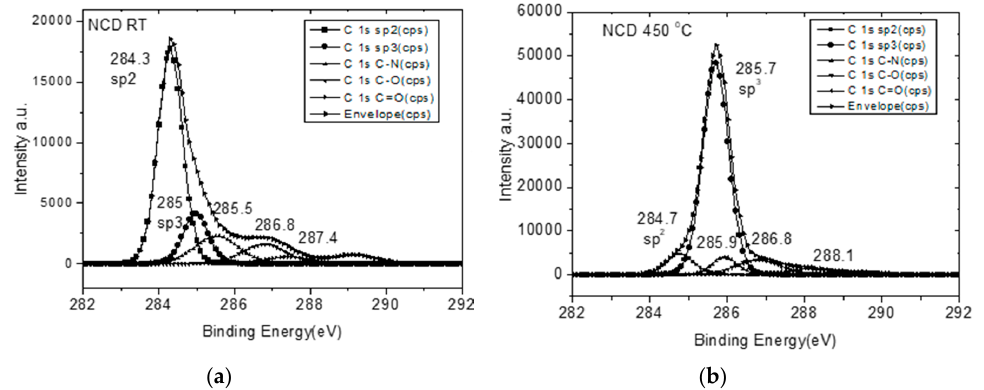
Figure 13. XPS spectra of the C 1s peak taken on the NCD film native surface at ( a ) RT and after the heating at ( b ) 450 °C.